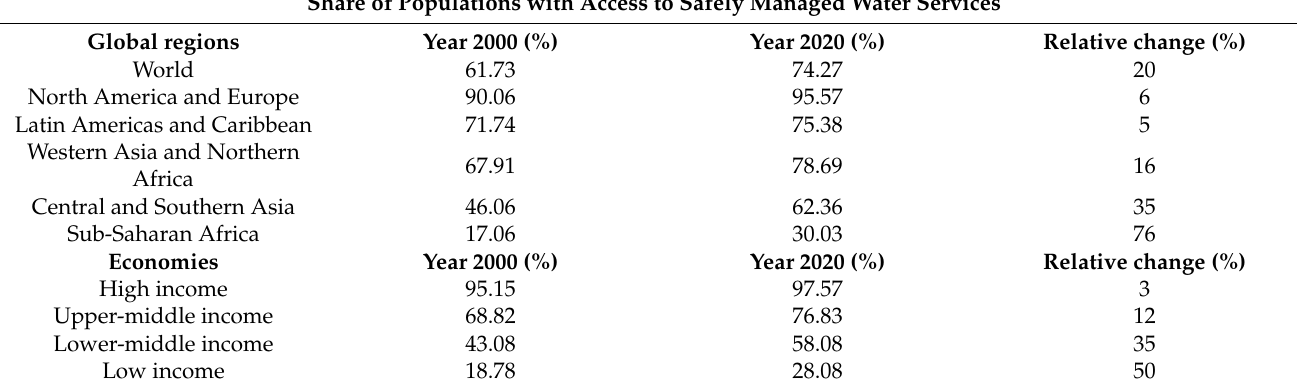
Table 1. Share of populations with access to safely managed water services by global regions and economies. [dataset] Ritchie, H. & Roser, M. 2021. Clean